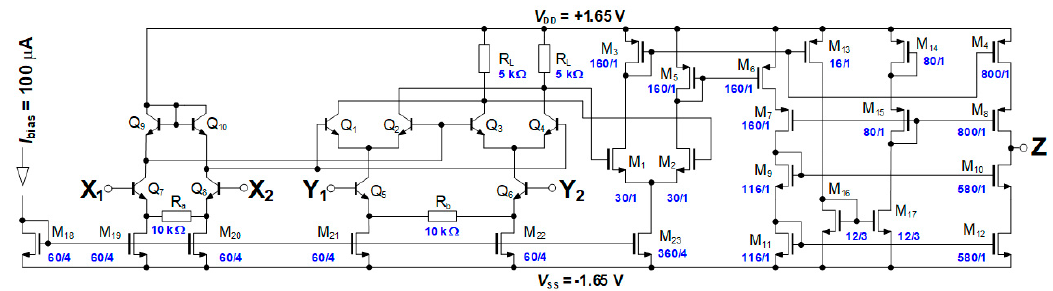
Figure A3. Full CMOS topology of the voltage multiplier with current output (BJT MLT).